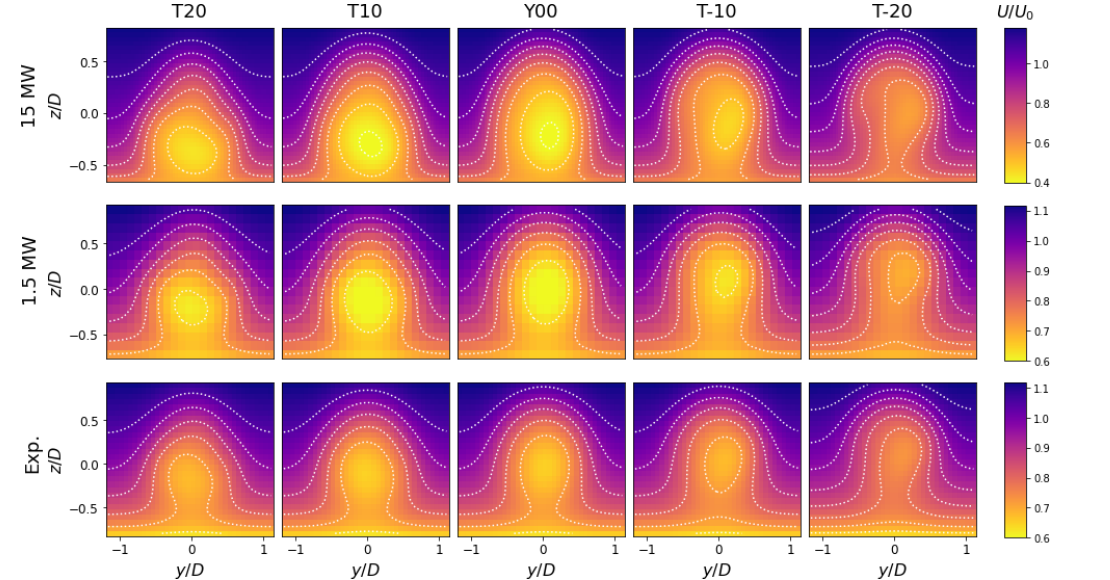
Figure 9. FLORIS streamwise flow fields across tilt angles at x/D = 3 for 15MW (top panels), 1.5MW (middle panels), and scaled model turbine (bottom panels) inputs. The curled wake model captures the effects of tilt misalignment with asymmetric wake deformation observed across turbine sizes.